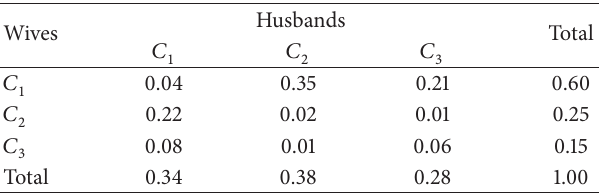
Table 2: Results from 𝑁 = 100 couples answering a multiple-choice question with three choice categories (fictitious